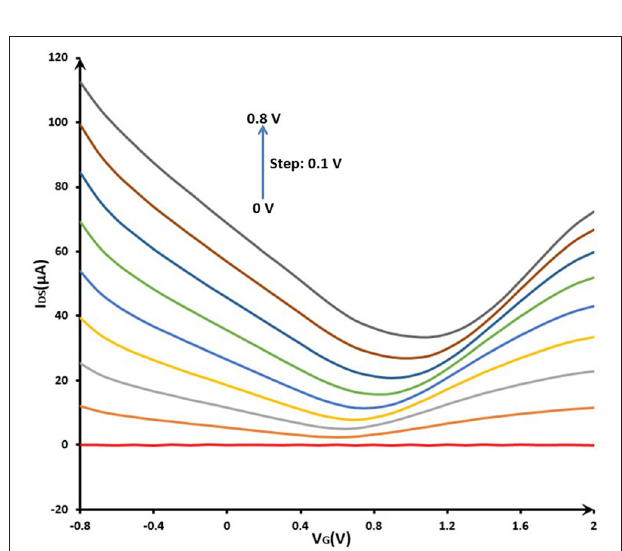
FIGURE 6 | Electrical properties (IDS-VG curve) of GFET array device before modification in phosphate buffer solution (0.01M PBS, pH 7.4): VG sweeping from − 0.8 to 2.0V; VDS changing from 0 to 0.8V with a step of 0.1V.